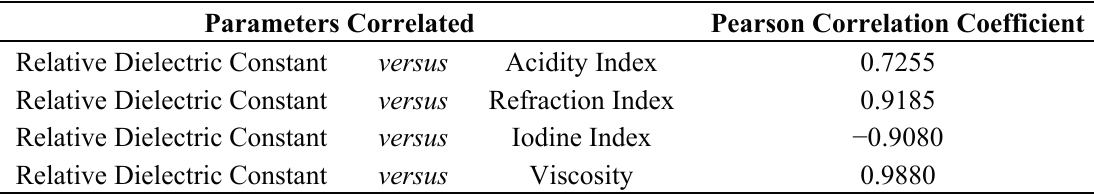
Figure 14. Scatterplots of correlation between Relative Dielectric Constant and the others physico-chemical parameters. Table 4. Pearson correlation coefficient to different physico-chemical